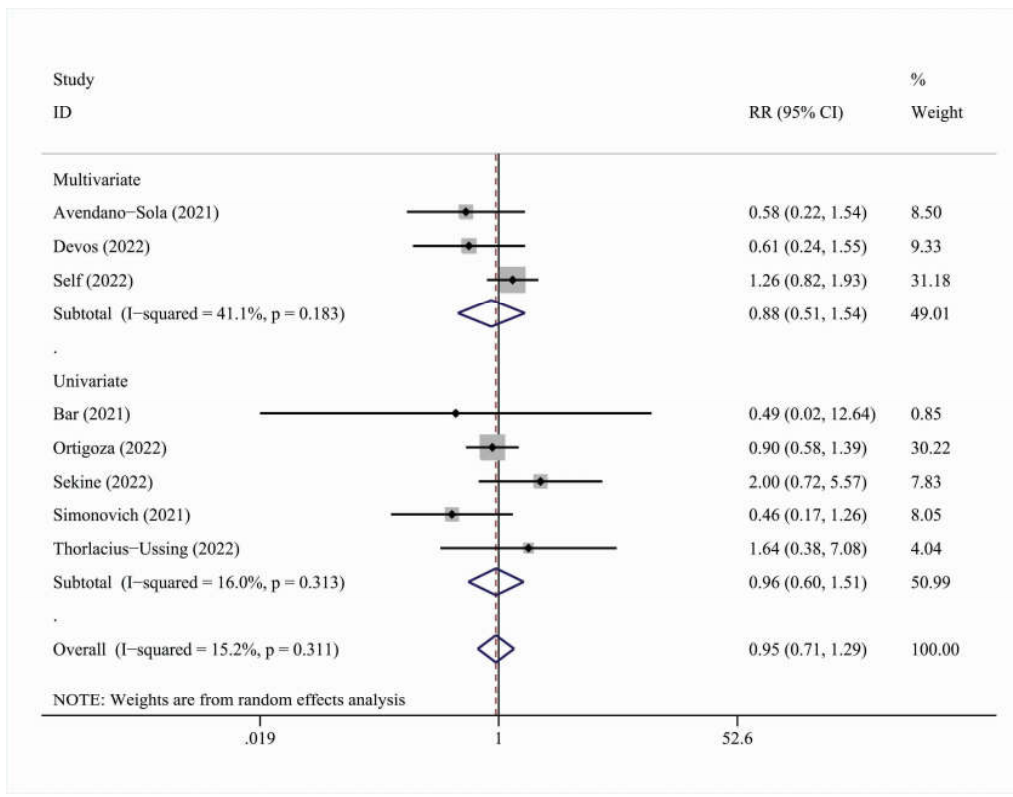
Figure 5 . Forest plot describing the association between convalescent plasma treatment and 14-day mortality. Apart from the overall analysis, the subanalysis on adjustment type is presented. Table 8. Results of the meta-analyses examining the association between convalescent plasma therapy and overall mortality (14-day); subgroup analyses by adjustment, multicenter status, blinding status and geographic region are presented.